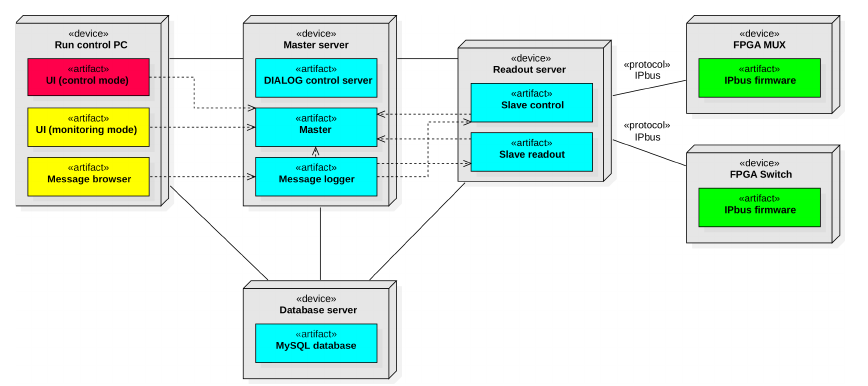
Figure 1. Software architecture of the iFDAQ software